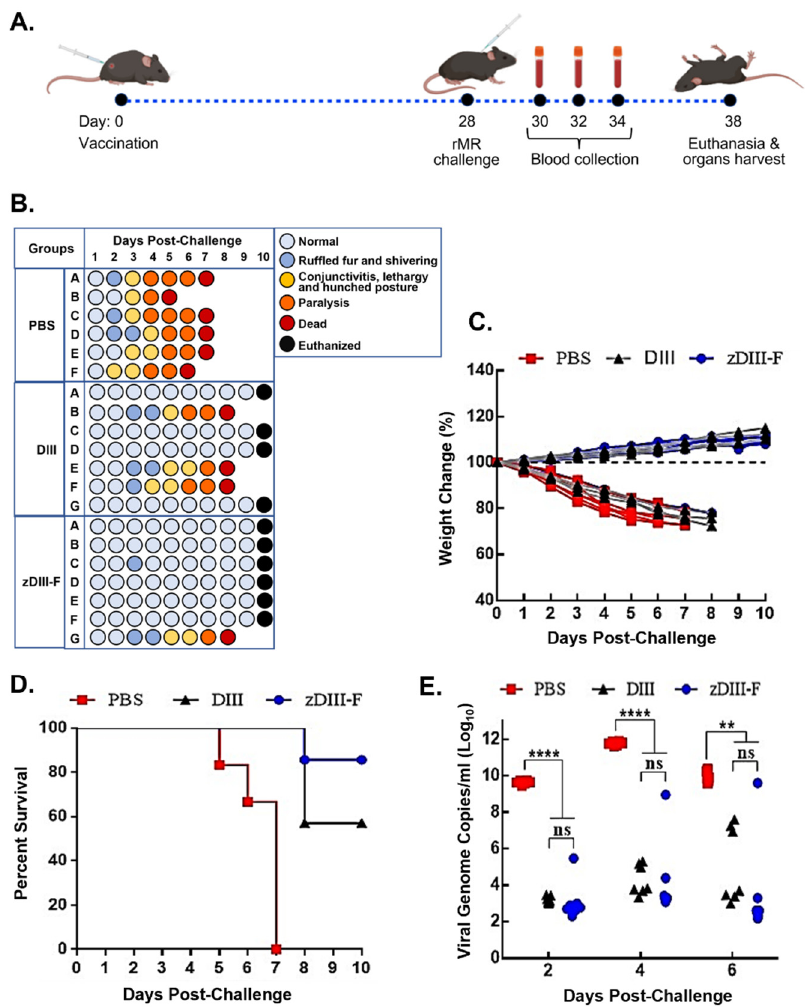
Figure 2. Vaccination with zDIII-F protects mice from lethal ZIKV challenge. ( A ) Scheme of vaccina- tion and challenge experiment. Groups of animals were vaccinated on day 0 and challenged with rMR ZIKV on day 28. Blood samples were collected on days 30, 32 and 34 (or 2, 4 and 6 days post- challenge). All surviving mice were euthanized at the end of the experiment on day 10. ( B ) Clinical symptoms in individual animals (identified as A to F/G in the groups) at various days following ZIKV challenge. ( C ) Percentage change in weight of individual animals in various groups following challenge with ZIKV. ( D ) Percent survival of animals in various groups following ZIKV challenge. ( E ) Viral genome copies in serum of animals on days 2, 4, and 6 post-challenge as measured by qRT-PCR. Data presented as mean ± SEM. ns, non-significant; **, p ≤ 0.01; and ****, p ≤ 0.0001. PBS group (n = 6), DIII group (n = 7) and zDIII-F group (n = 7). Mice were